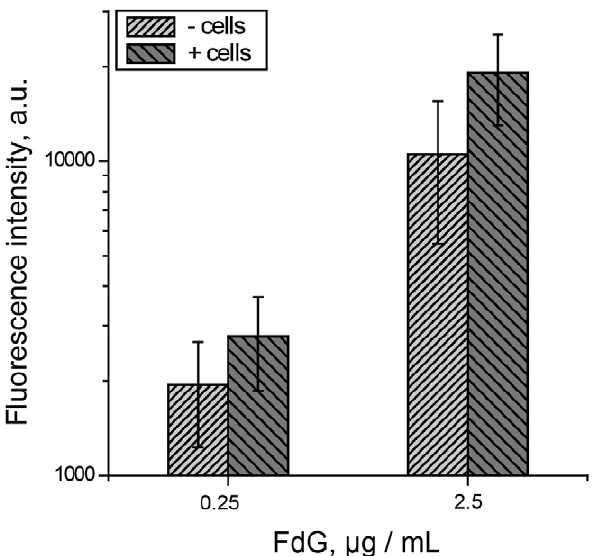
Figure 4. Conversion of the prodrug by the enzyme within a PVA hydrogel matrix is not impaired by the presence of serum, i.e. possible absorption of proteins, and adhesion of mammalian cells. Experimental conditions: 1 g/L b -Glu in polymer solution, 30 min reaction time. Presented results (mean 6 st.dev.) are average over at least 3 independent experiments, 3 replicates each.